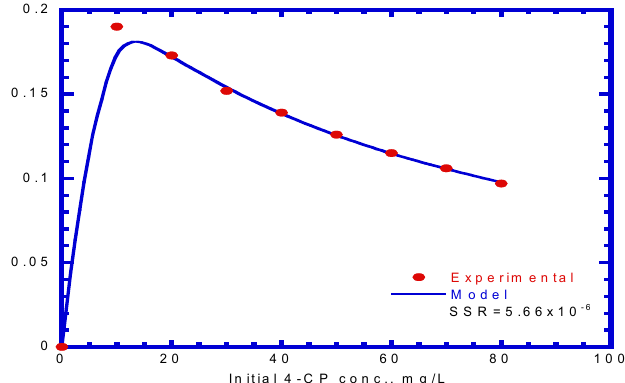
Figure 6. Specific utilization rate versus initial 4-CP concentration and fitted by the Haldane model to determine kinetic parameters of maximum specific utilization rate of 4-CP (k CP ), half-saturation constant for 4-CP (K S,CP ) and self-inhibition constant of 4-CP (K I,CP ). The CP k value obtained in the present study was much higher than that obtained from other studies ranging from 0.02 to 0.229 h ‒ 1 with pure or mixed cultures [16,29,32]. K The CPS,